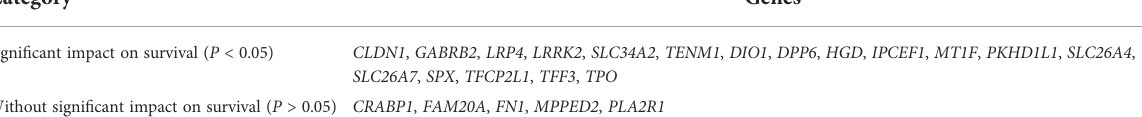
TABLE 2 Kaplan – Meier-Plotter analysis of the association between prognosis and 23 differentially expressed genes. Category Genes Signi fi cant impact on survival ( P < 0.05)